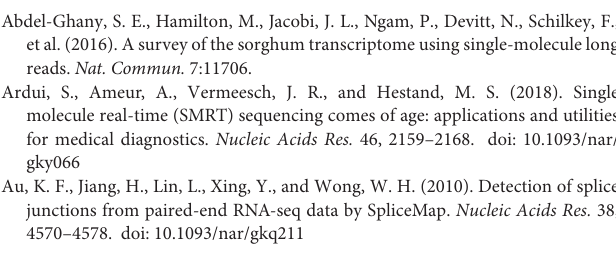
to the reference genome as determined by STAR.